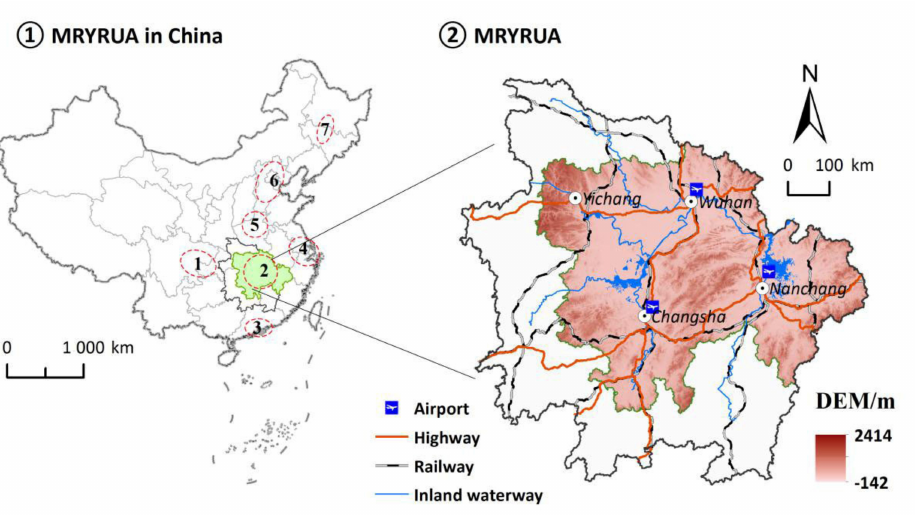
Figure 1. Location of the Middle Reaches of the Yangtze River Urban Agglomerations (MRYRUA) in China. Notes: 1, 2, 3, 4, 5, 6, and 7 in the figure represent Chengdu-Chongqing Urban Ag- glomeration, the Middle Reaches of the Yangtze River Urban Agglomerations, Pearl River Delta Urban Agglomeration, Yangtze River Delta Urban Agglomeration, Central Plains Urban Agglomera- tion, Beijing-Tianjin-Hebei Urban Agglomeration, and Harbin-Changchun Urban Agglomeration,